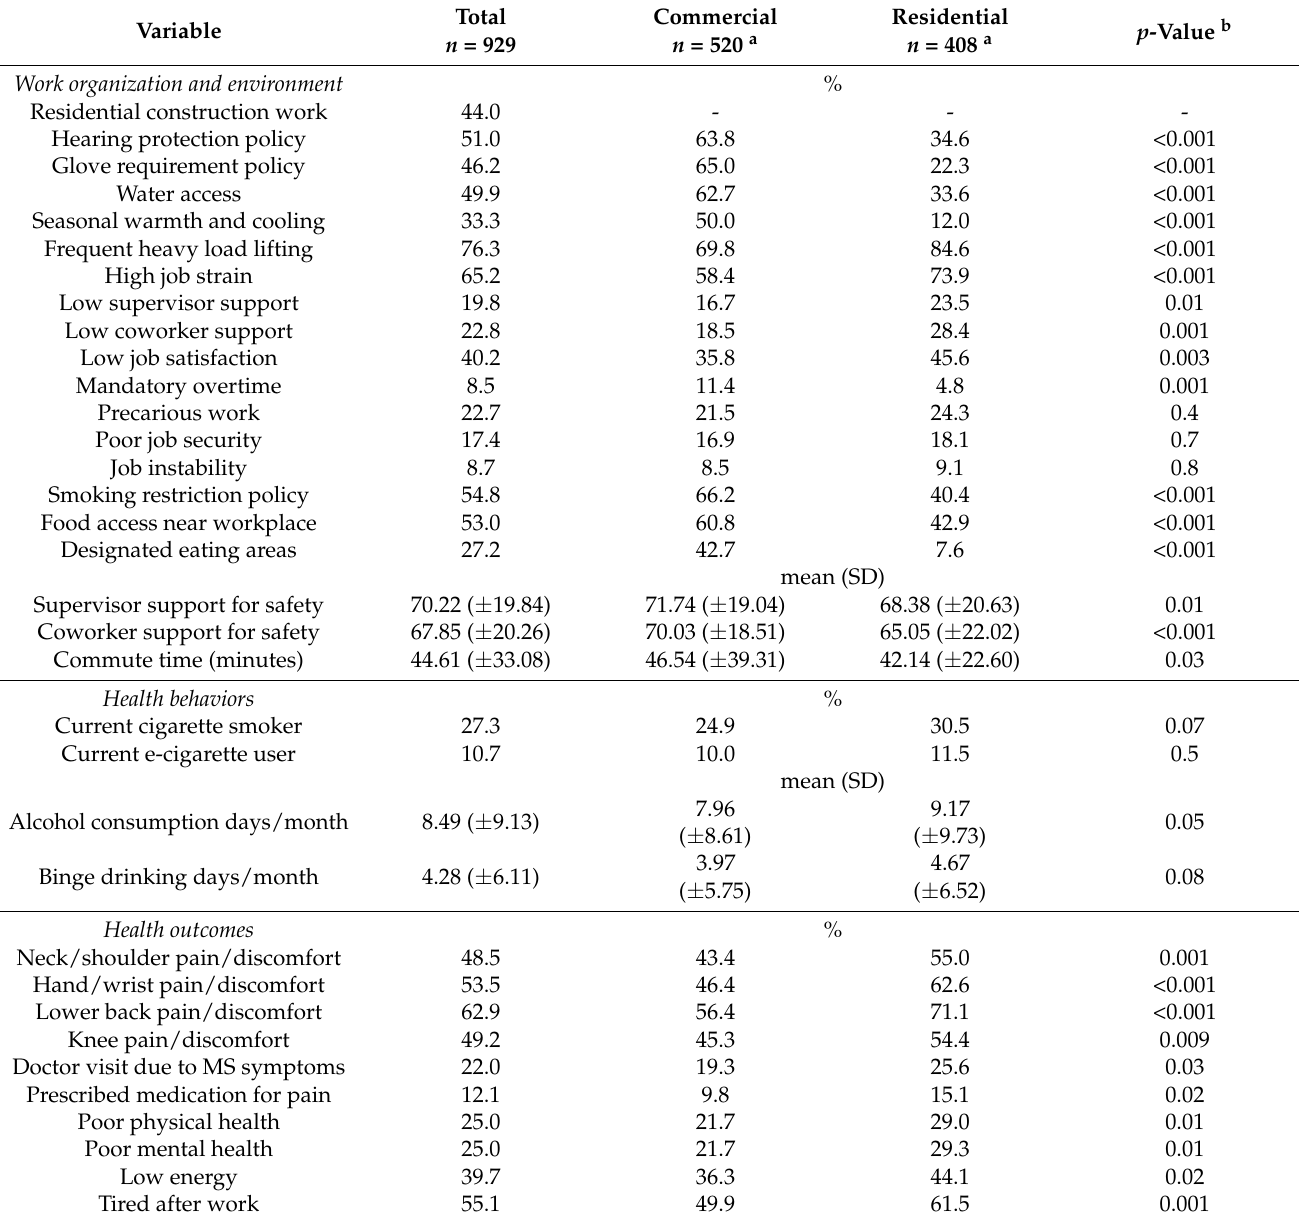
Table 2. Prevalence and means of work outcomes, health outcomes, health behaviors, and work factors between residential and commercial